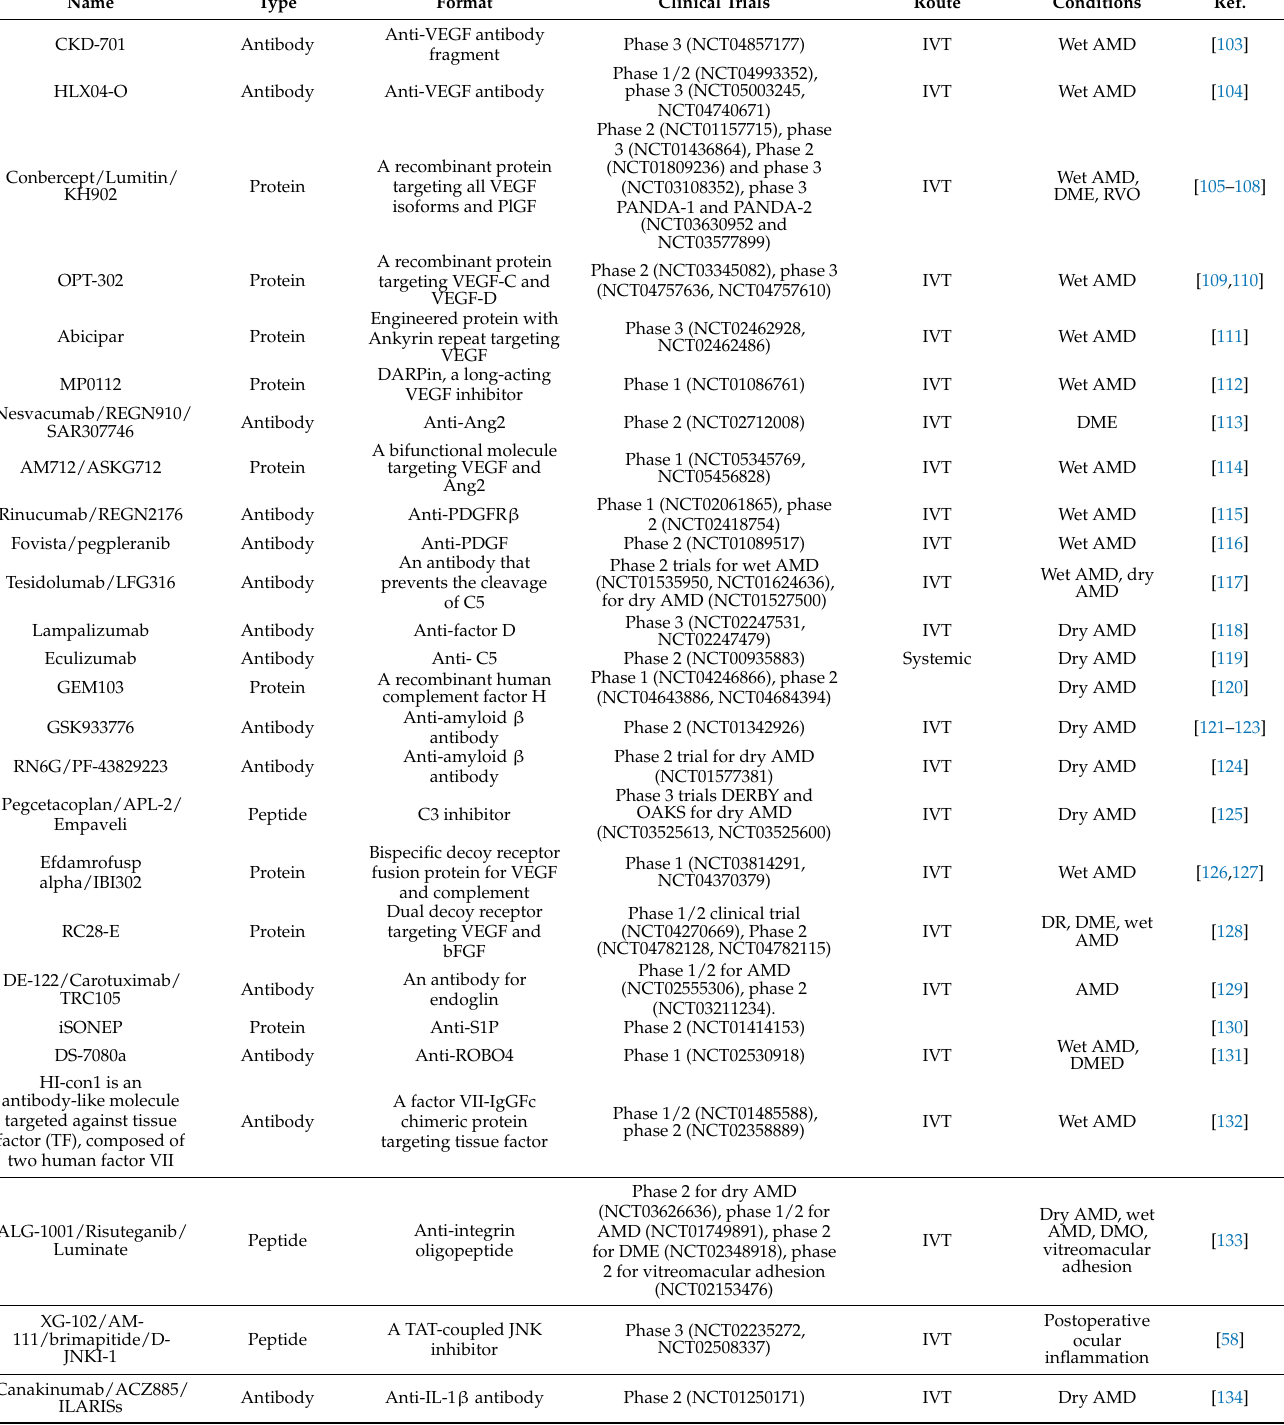
Table 2. Developing peptide/protein-based drugs for eye diseases in clinical